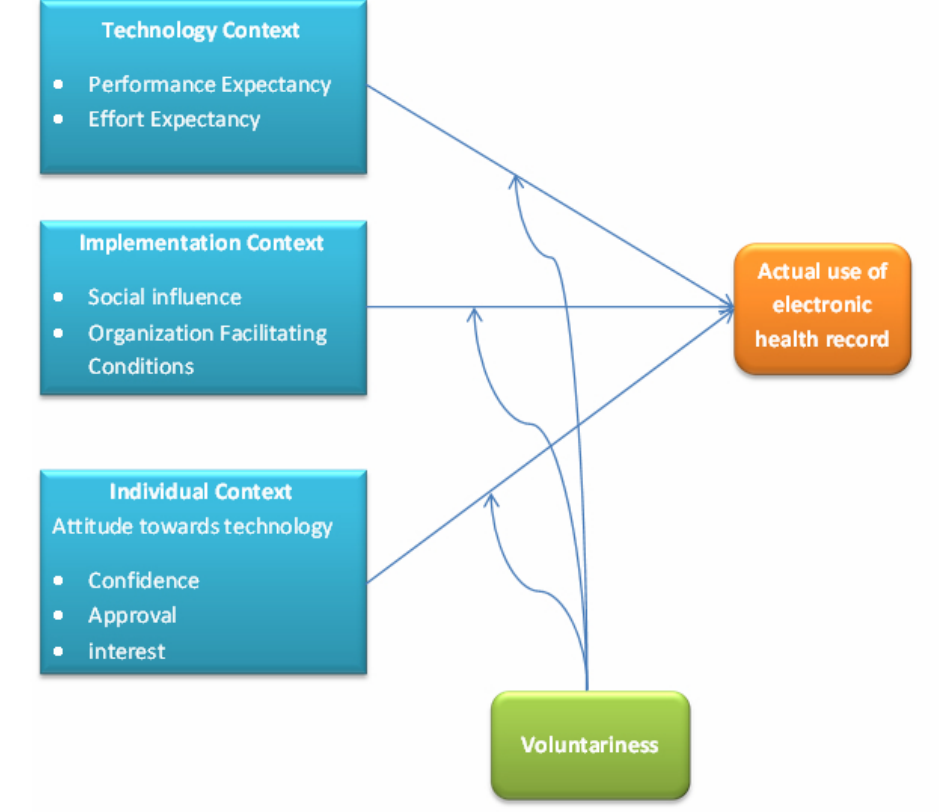
Figure 1. Conceptual model of the moderating effects of voluntariness on actual